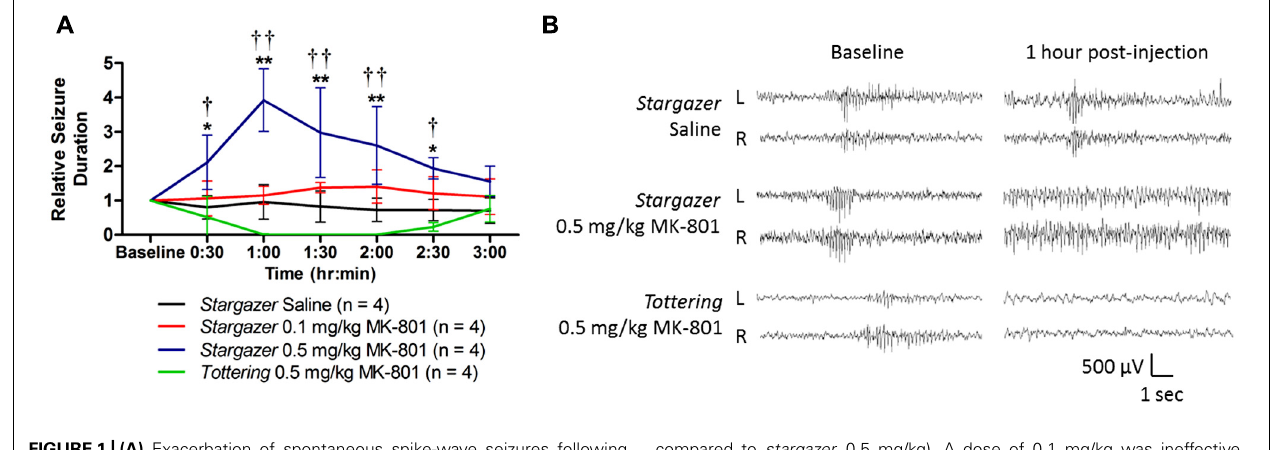
FIGURE 1 | (A) Exacerbation of spontaneous spike-wave seizures following MK-801 in stargazer mice. Compared to ip saline, the total seizure duration is elevated by up to 448% 1 h post-injection with 0.5 mg/kg in stargazer mutants (* p < 0.05, ** p < 0.0001). At the same dose, seizures are entirely suppressed in tottering mice ( † p < 0.01, †† p < 0.0001